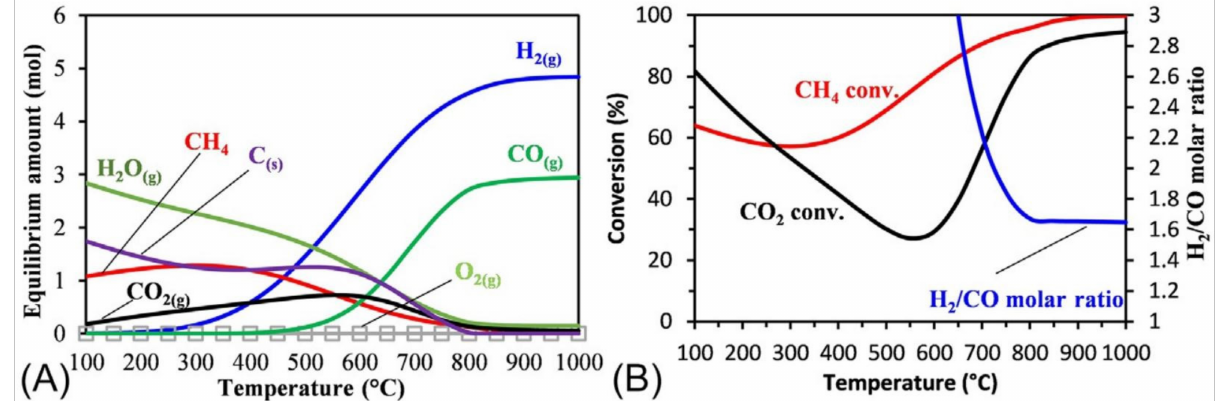
Figure 6. Thermodynamic equilibrium plot for TRM as a function of temperature (T = 100–1000 ◦ C) at 1 bar with CH 4 :CO 2 :H 2 O:O 2 = 2:1:1:0.1. ( A ) Equilibrium amounts for all species; ( B ) CH 4 and CO